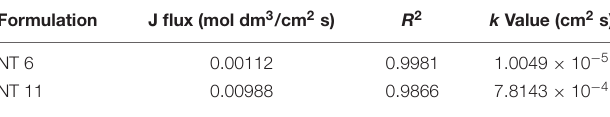
TABLE 3 | In vitro release parameters of NT 6 and NT